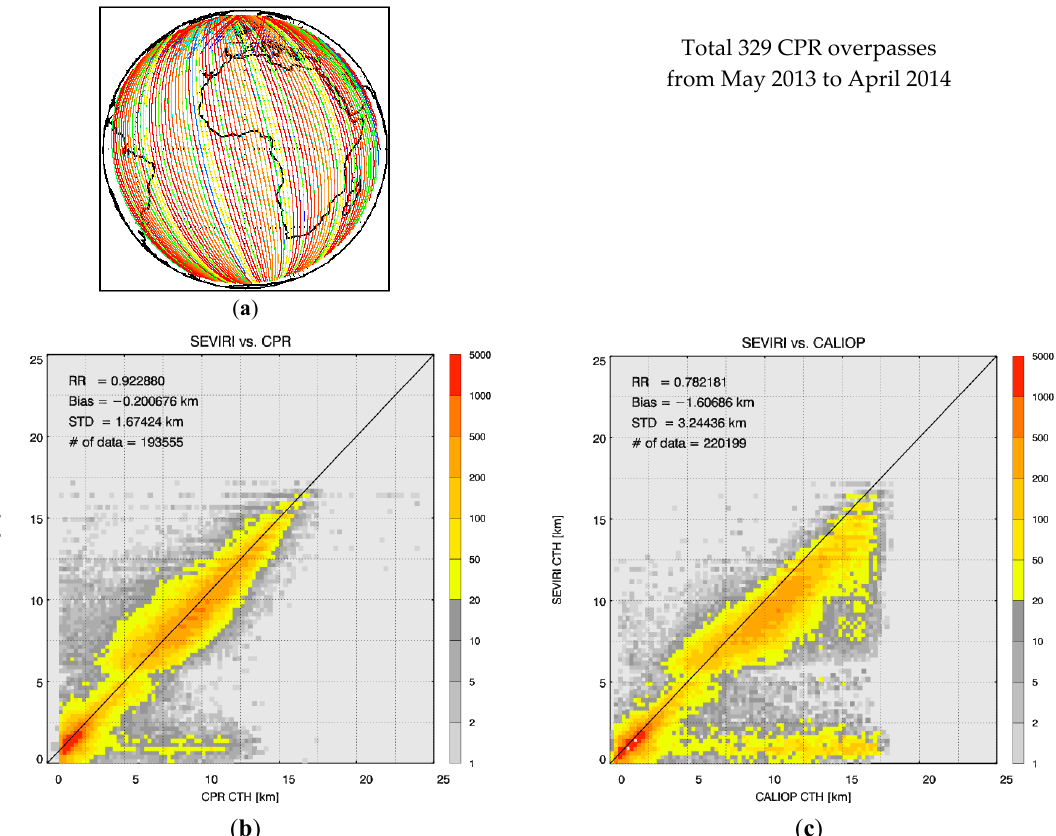
Figure 4. ( a ) Geographical distribution of collocation dataset used in this study and scatter plots for Spinning Enhanced Visible and Infrared Imager (SEVIRI) cloud-top height (CTH) with comparison to ( b ) Cloud Profiling Radar (CPR) CTH and ( c ) Cloud-Aerosol LiDAR with Orthogonal Polarization (CALIOP) CTH.